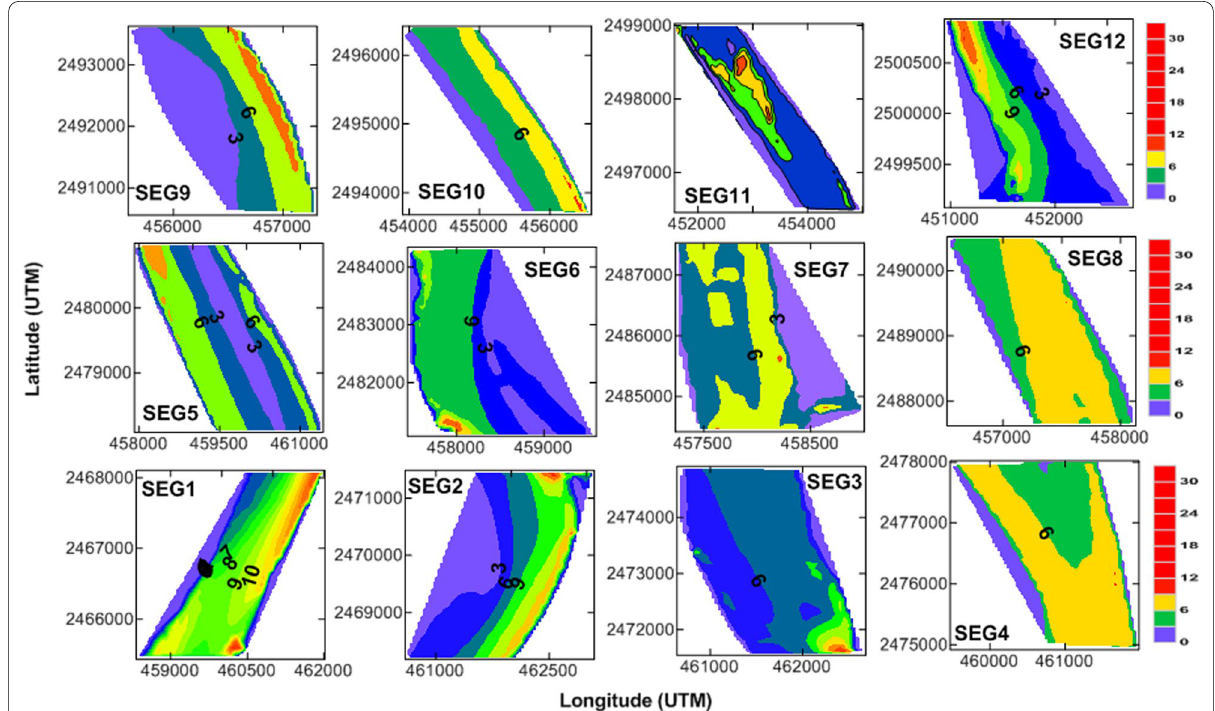
Fig. 3 Segments bathymetry (3 km each) of the Pasur River Estuary from Harbaria (SEG1) to Chalna (SEG12). Contour of depth in feet